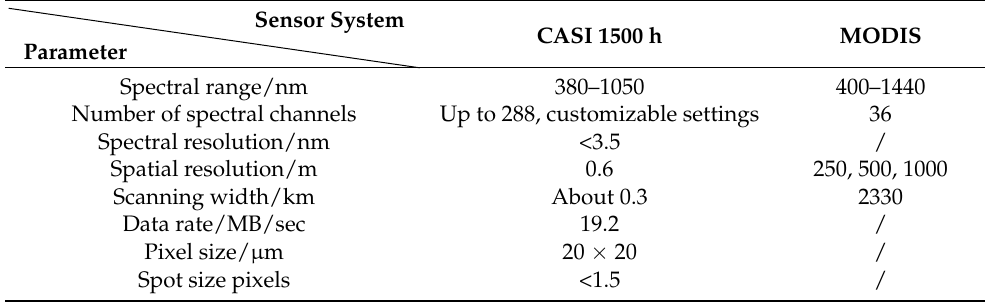
Table 1. The technical parameters of CASI 1500 h in comparison with MODIS.